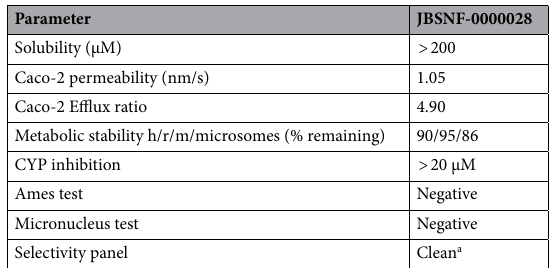
Table 4. ADME, and safety profile of JBSNF-0000028. a Selectivity of JBSNF-0000028 against a panel of diverse targets is shown in Supplementary Table 1.